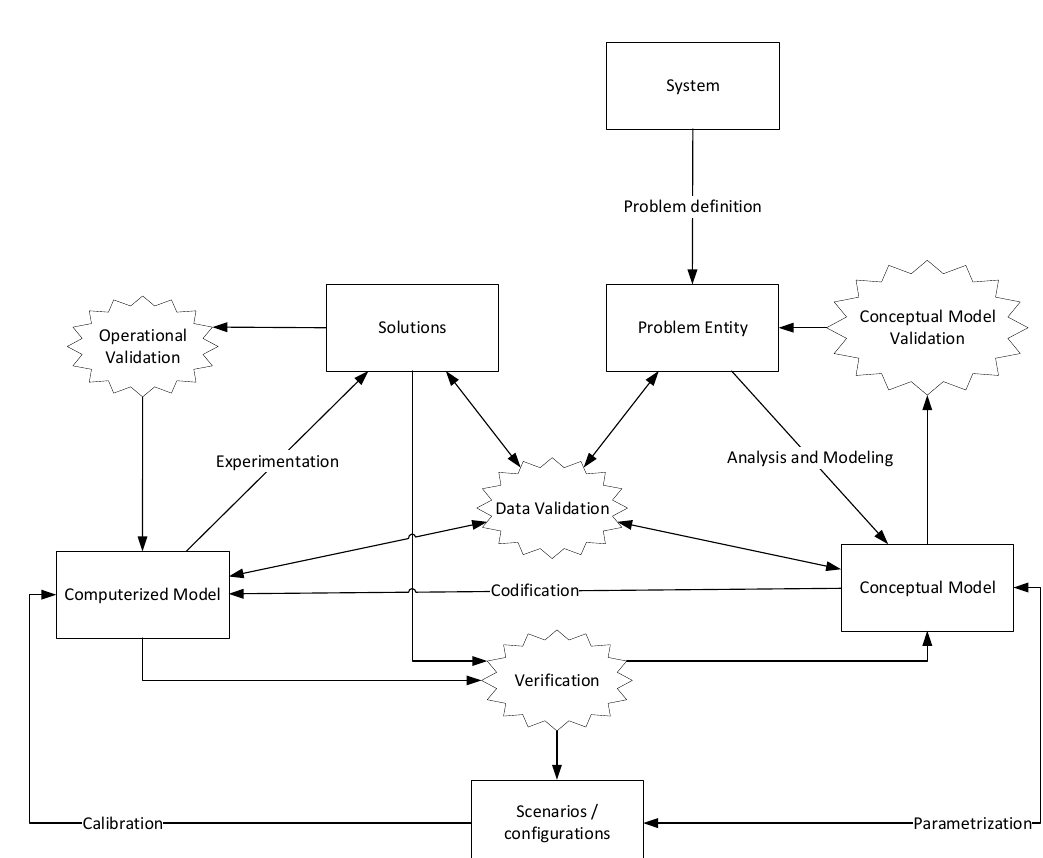
Figure 1. The process we follow to do the estimation of the model parameters.